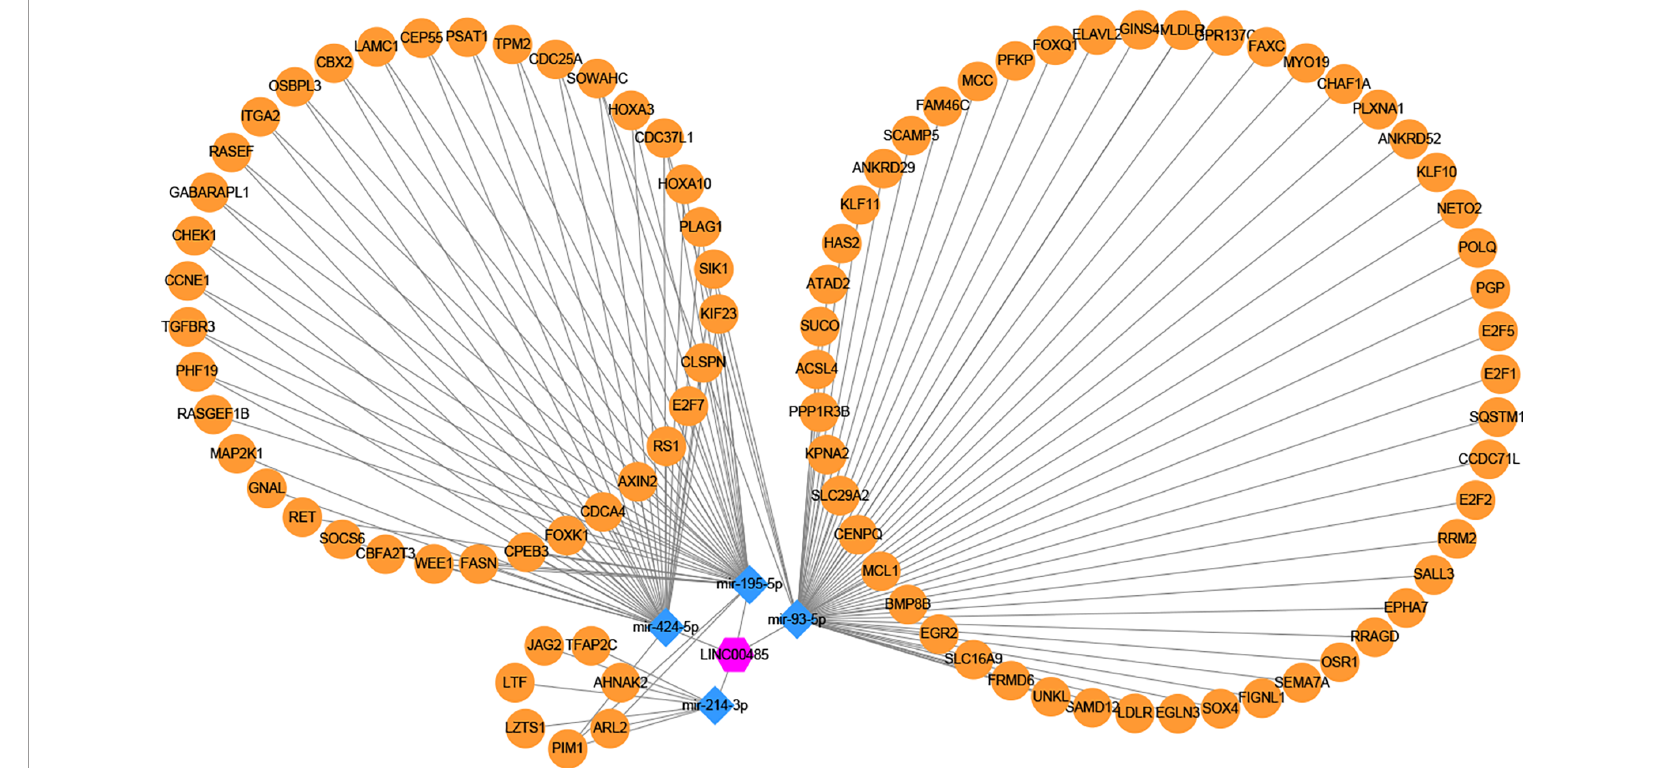
FIGURE 6 | Construction of lncRNA – miRNA – mRNA regulatory network. One candidate lncRNA (purple hexagon), four candidate miRNAs (blue diamond) and ninety-four potential downstream mRNAs (yellow ellipse) form the network. The candidate miRNAs of LINC00485 were predicted by miRcode and veri fi ed by correlation analysis and meta-analysis. The potential downstream mRNAs of candidate miRNAs were retrieved from miRDB, miRTarBase and TargetScan. The regulatory network of lncRNA – miRNA – mRNA was constructed and visualized by Cytoscape. Edges represent the interactions between these